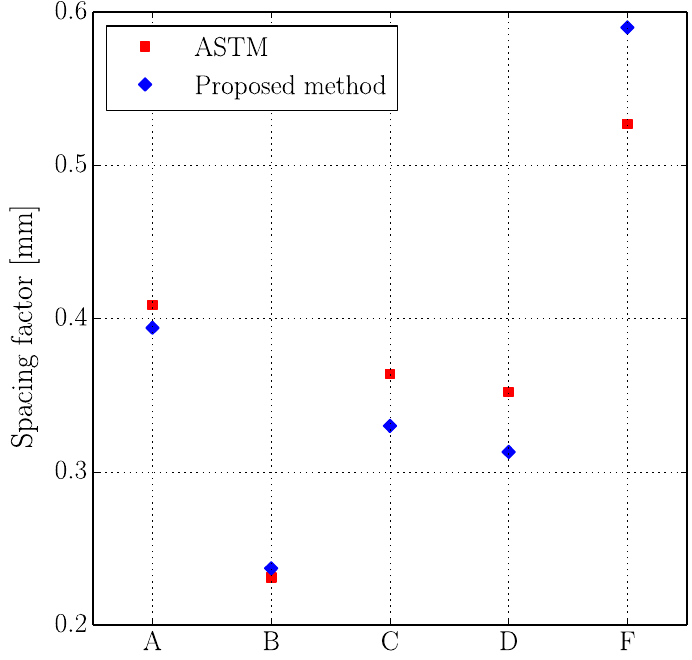
Figure 11. Results of the paste content (%) of the slabs studied using the original and the proposed methods.